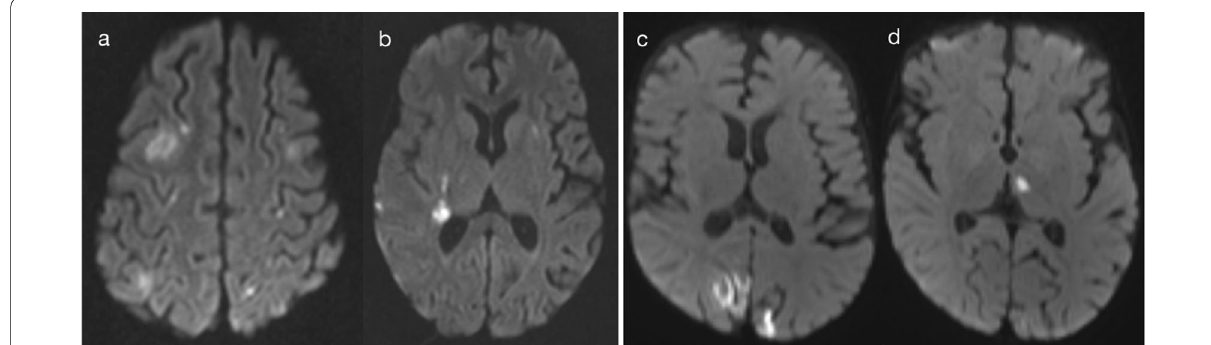
Fig. 4 Restricted diffusion in supratentorial grey matter—scattered lesions (Pattern 2A). Case 1: 4‑year‑old child with somnolence and hyperaesthesia, in the setting of acute lymphoblastic leukaemia (ALL) and Scedosporium prolificans fungaemia. DWI ( a , b ) demonstrated scattered foci of restricted diffusion, mainly affecting cortical grey matter with a bilateral though asymmetric distribution. Case 2: 4‑month‑old infant with respiratory distress, in the setting of HIV, Pneumocystis jiroveci pneumonia and an abnormal cranial ultrasound. DWI ( c , d ) demonstrated scattered foci of restricted diffusion, mainly affecting cortical grey matter with a bilateral though asymmetric distribution